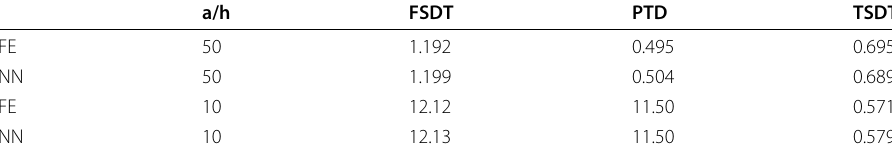
Table6 0/90/0, influence of a/h on some particular cases from Figs. 8 and 9 a/h FSDT PTD TSDT FE 50 1.192 0.495 0.695 NN 50 1.199 0.504 0.689 FE 10 12.12 11.50 0.571 NN 10 12.13 11.50